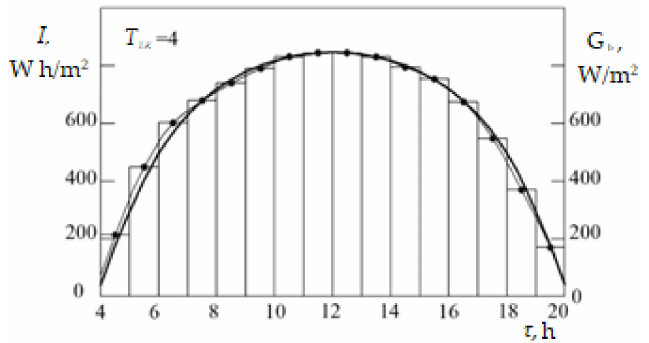
Figure 4. Hourly data of energy I (columns) and intensity of the flux G b (own research): natural—a thin bypass line; the modeled one at T LK = 4—a line of standard width (the meteorological station “Kovel”); time by the Sunbelt.